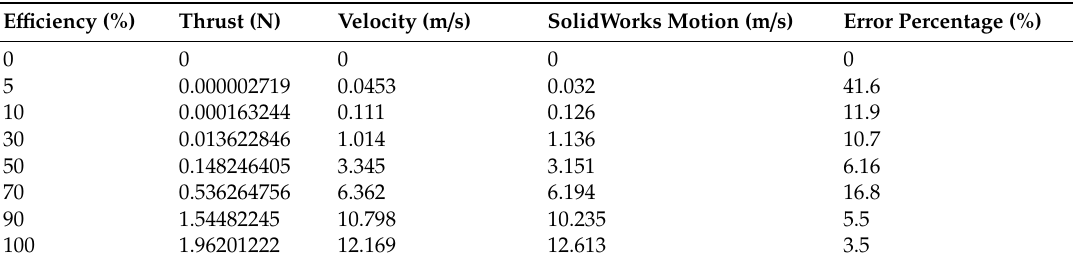
Figure 3. SolidWorks Motion Analysis. Table 4. Calculated Results with Efficiency.